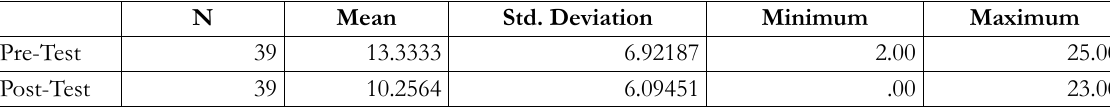
Table 15. Descriptive statistics of the pre- and the